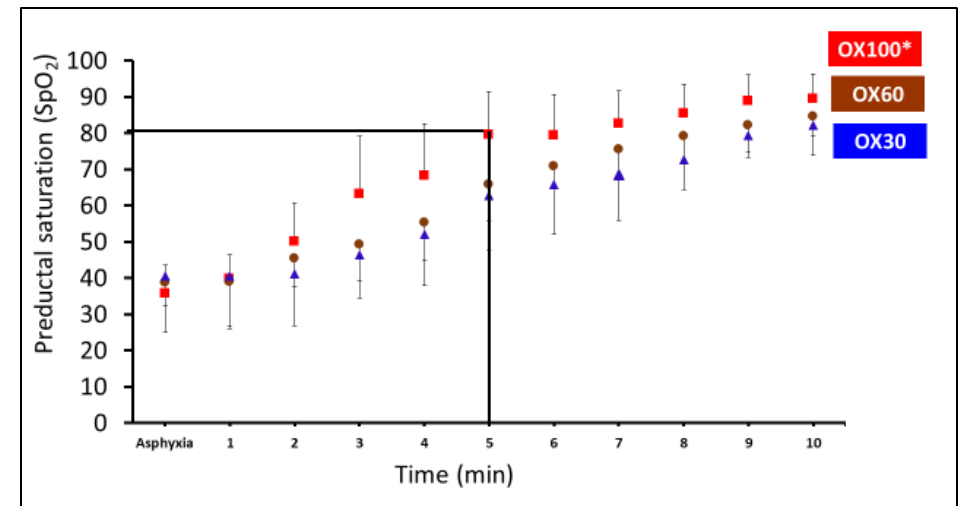
Figure 1. The graphs here shows the preductal saturations (SpO 2 ) for OX30 (triangle), OX60 (circle), and OX100 (square) on the y ‐ axis and the time from birth on the x ‐ axis. The preductal SpO 2 was significantly higher with OX100 than with OX30 in the first 10 min (* p < 0.01, denotes significantly by ANOVA). The black intersecting line shows the 5 min ( x ‐ axis) and 80% SpO 2 mark (on y ‐ axis). Data are represented as average and standard deviation.